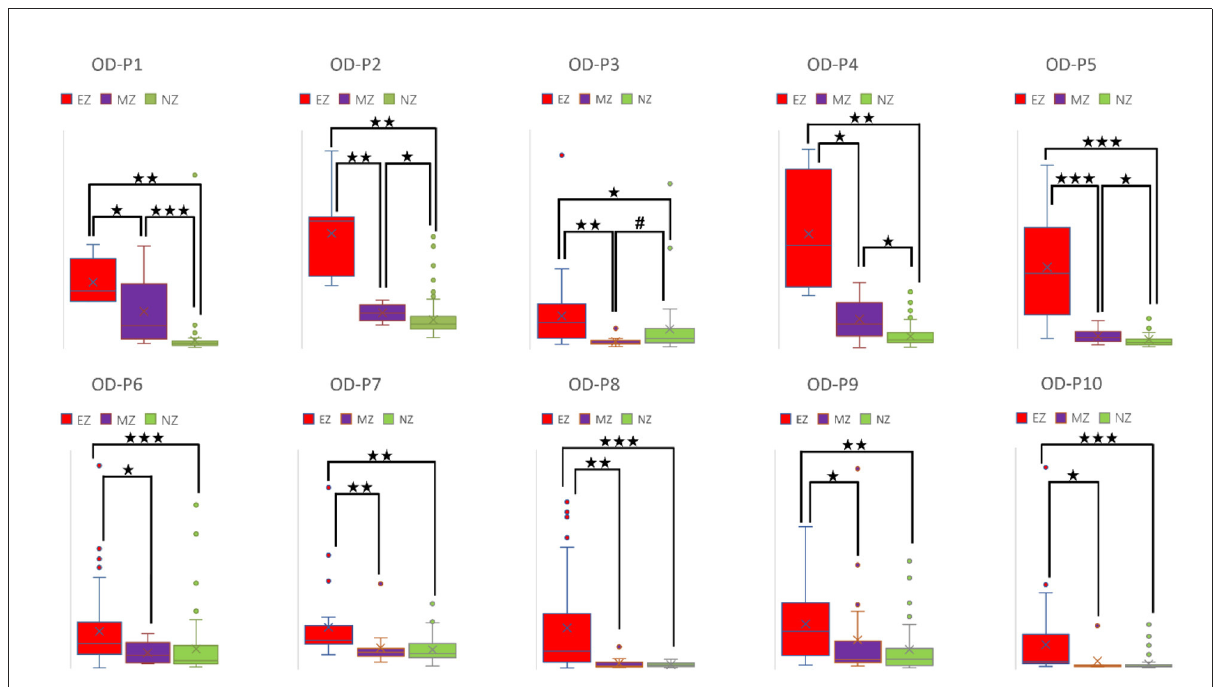
FIGURE5 Box plot of OD of all ten patients for EZ, MZ, and NZ (P1 represents patient 1; ⋆ represents p < 0.05 with EZ > MZ, EZ > NZ, or MZ > NZ; ⋆⋆ represents p < 0.001 with EZ > MZ, EZ > NZ, or MZ > NZ; ⋆⋆⋆ represents p < 0.00001 with EZ > MZ, EZ > NZ, or MZ > NZ; # represents p < 0.05 with EZ < MZ, EZ < NZ, or MZ < NZ; Mann-Whitney U test [two–tailed]). OD, out–degree; EZ, epileptogenic zone; MZ, margin zone; NZ, normal